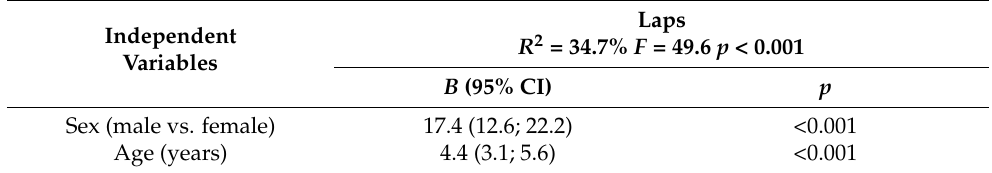
Table 2. Regression analysis results: sex and age vs. fitness test results (number of laps). Independent Variables